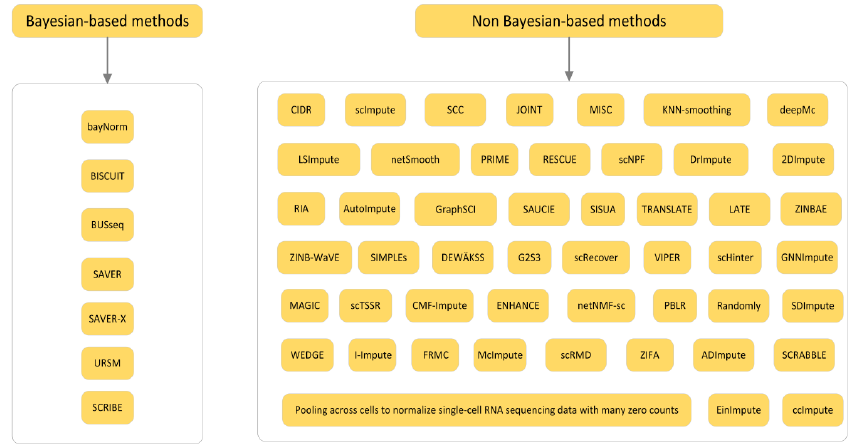
Figure 3. The third classification of imputation method for the detailed division of global methods and local methods.